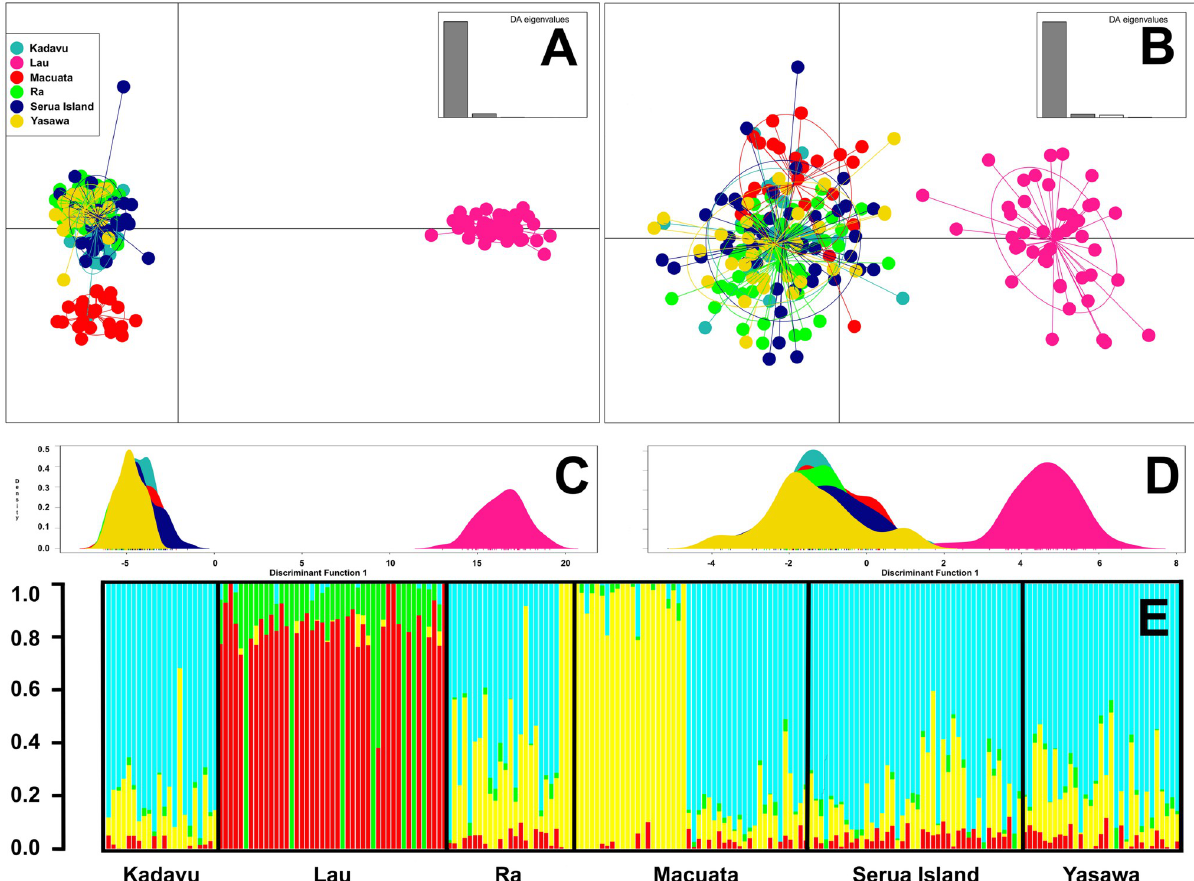
Fig 3. Visualisation of genetic structure in Fijian Holothuria scabra generated using Discriminant Analysis of Principal Components (DAPC) scatterplots and ADMIXTURE barplot. A : Alpha-score optimised DAPC scatterplot with 11 DFs (6896 selectively neutral SNPs) and B : Alpha-score optimised DAPC with 7 DFs (186 putatively adaptive SNPs). C and D depict DAPC plots generated using a single discriminant factor for the 6896 selectively neutral and 186 putatively adaptive SNPs, respectively. E shows an ADMIXTURE barplot of proportional ancestral contributions at a k = 4